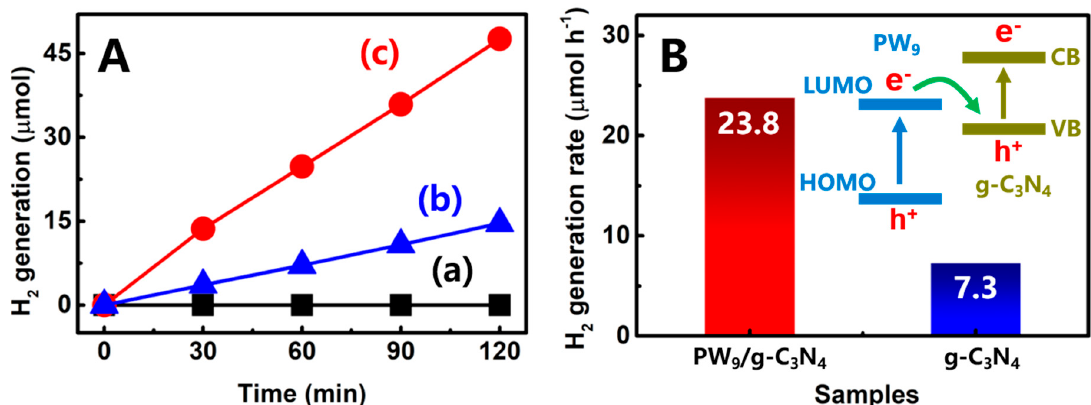
Figure 5. ( A ) Time-dependent photocatalytic H 2 -gereration plots over the different samples under simulated sunlight irradiation: (a) PW 9 ; (b) g-C 3 N 4 NSs; (c) PW 9 /g-C 3 N 4 heterojunction NSs; ( B ) H 2 - simulated sunlight irradiation: (a) PW 9 ; (b) g-C 3 N 4 NSs; (c) PW 9 / g-C 3 N 4 heterojunction NSs; generation rates of the PW 9 /g-C 3 N 4 heterojunction and g-C 3 N 4 NSs. ( B ) H 2 -generation rates of the PW 9 / g-C 3 N 4 heterojunction and g-C 3 N 4 NSs.